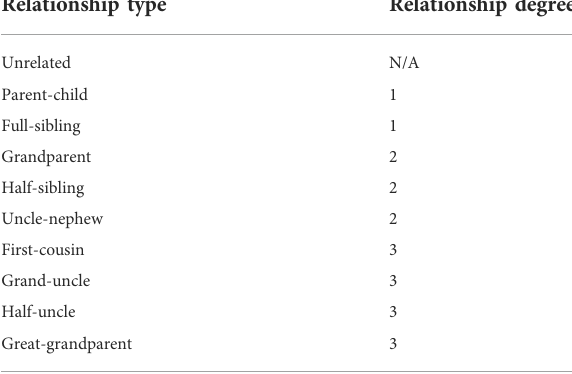
TABLE 1 The list of 10 relationship types in Supplementary Figure